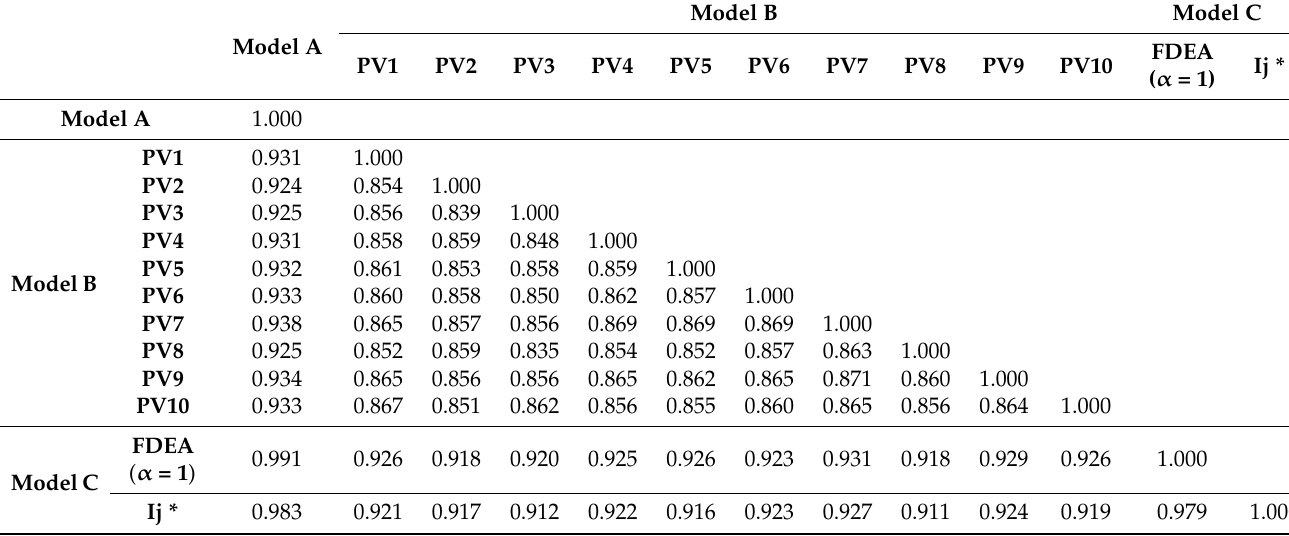
Table 5. Correlation coefficients among efficiency scores estimated with different approaches.